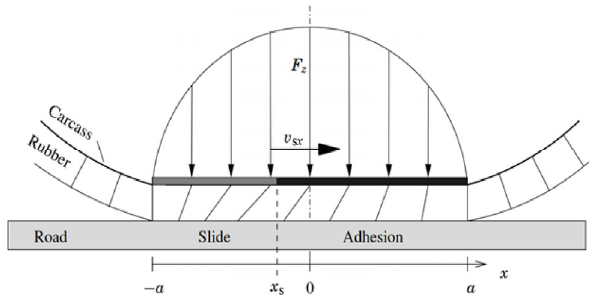
Fig. 14 The schematic of adhesion and sliding regions in the contact patch [123].